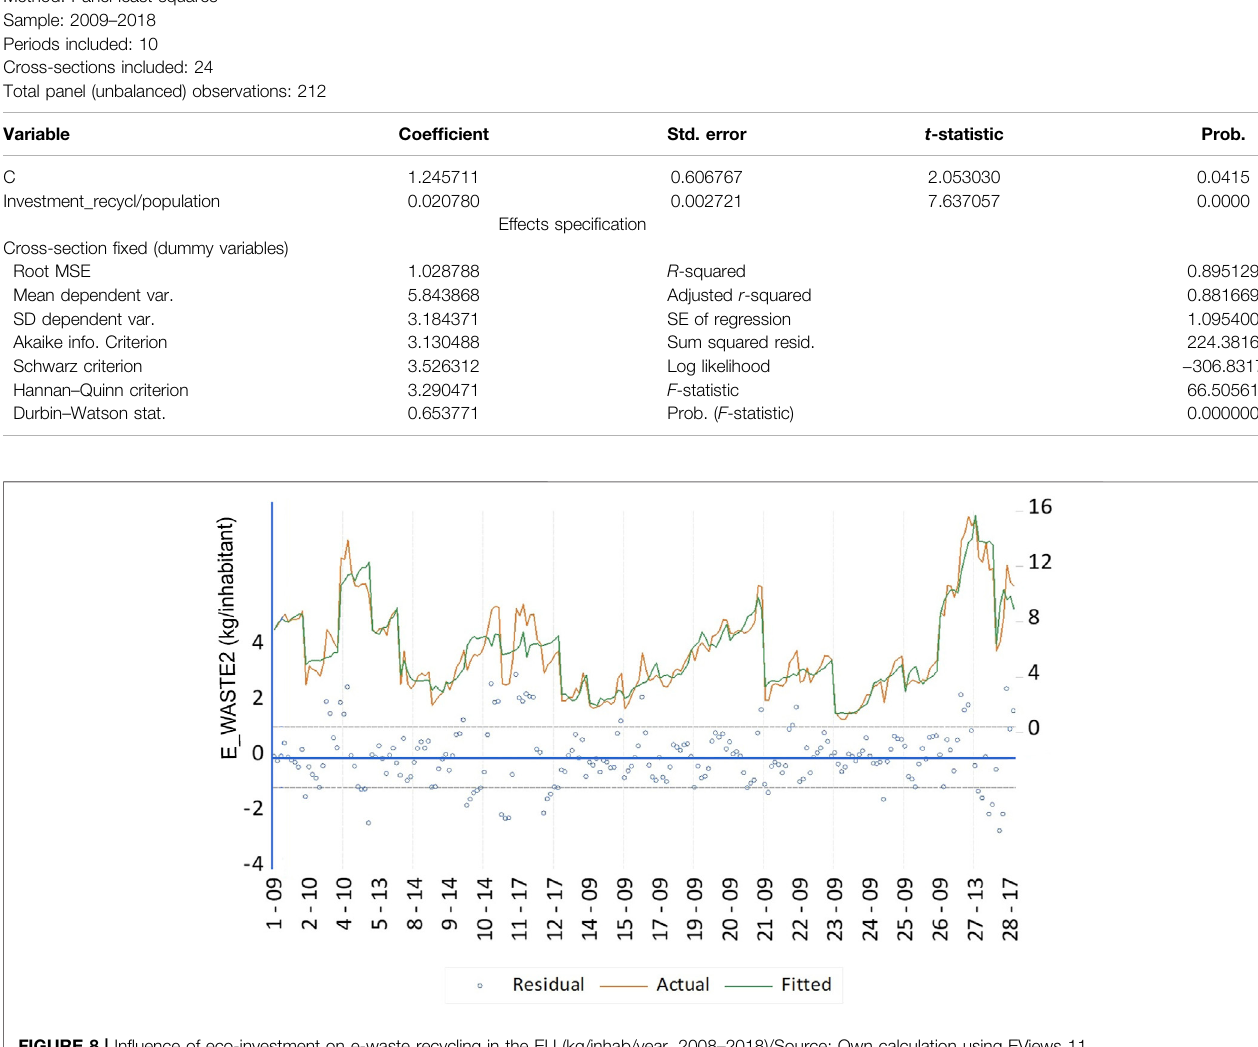
Frontiers in Environmental Science |